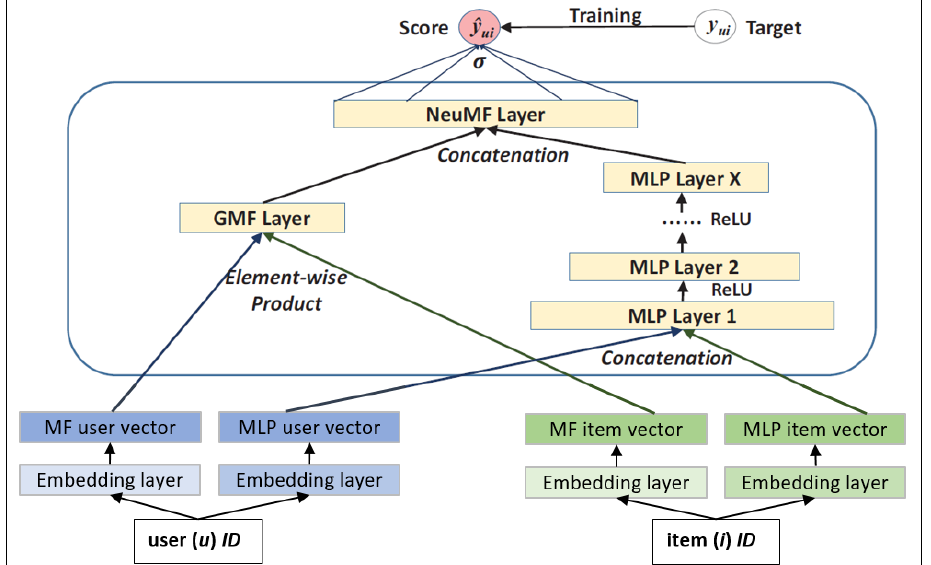
Figure 6. Architecture of the modified NNMF model [21].